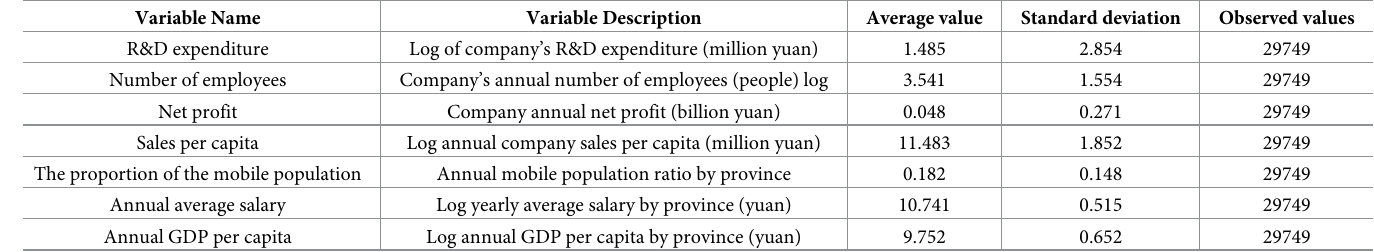
Table 1. Descriptive statistics of full sample